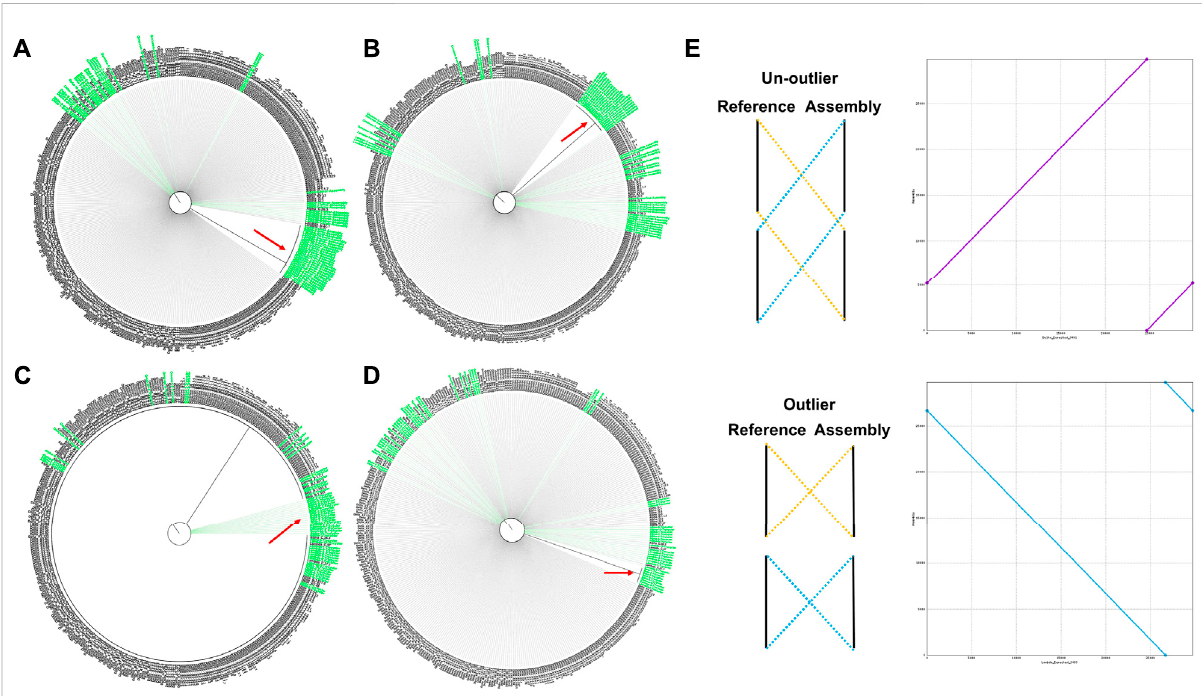
FIGURE 3 Assembly accuracy affects phylogenetic tree analysis. (A) The assembly results of FlyE to analyze simulated data with errors. (B) The assembly results of FlyE to analyze simulated data without errors. (C) The assemblies and consensus results of Trycycler to analyze simulated data with errors, which combination with 10 high-quality assembly results. (D) The assemblies and consensus results of Trycycler to analyze simulated data with errors, which combination with 23 high-quality assembly results. (E) The structural problems of the assembled draft genomes resulted in the outlier samples, which could not effectively distinguish the lineage.